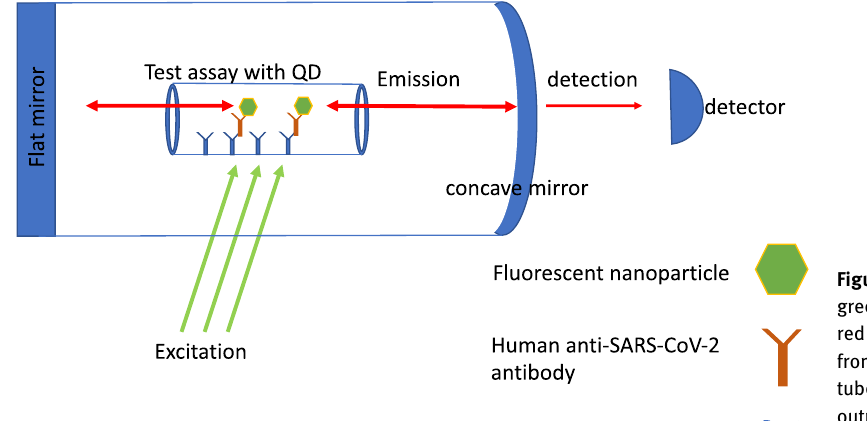
Figure 4: Excitation in one-sided cavity. The green arrows show the excitation light. The red double-arrows show the fluorescence from quantum dots inside the capillary tube. The red arrow on the right shows the outputofthecavitywhichiscollectedbythe detector. Details of the test capillary inside the cavity are shown in Figure